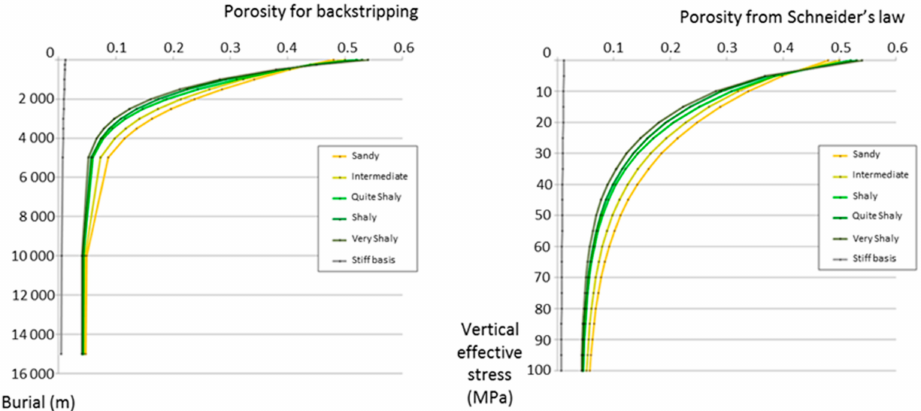
Figure A1. Porosity for the backward restoration and the forward basin simulator. At significant burial depths (e.g., 1 to 8 km), the shalier the facies, the less porous the sediment. However, this ranking is inverted at deposition.